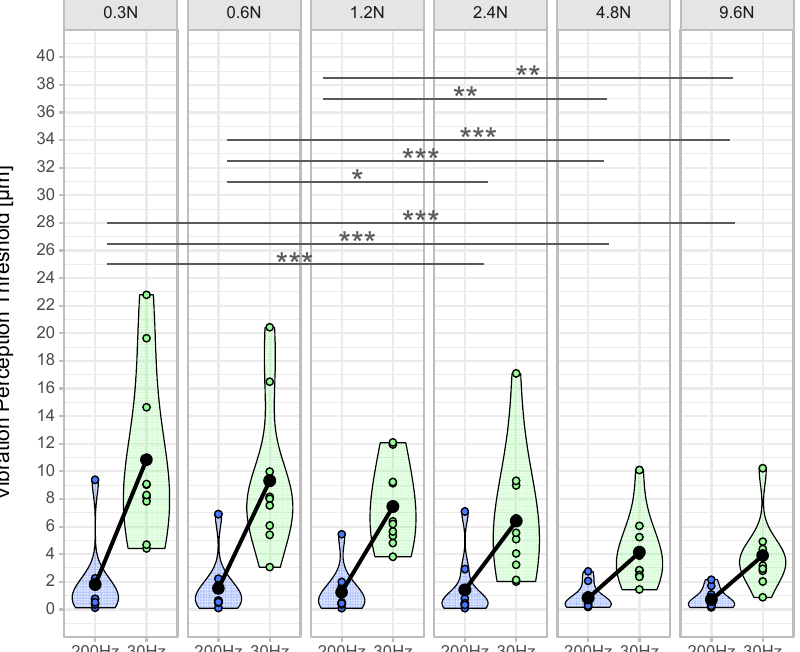
Figure 4. Vibration perception thresholds per contact force and frequency. The violin plots show the density of the distribution for the vibration perception thresholds (VPT) for the frequencies 200 Hz (blue) and 30 Hz (green) of the respective contact forces based on the width of the plot ( n = 10 per contact force condition). The individual points within the violin plots represent the averaged VPT (mean out of three VPT measurements per contact force condition) of each subject. The black dot is the mean value of all subjects. The connecting line between the black dots represents the mean difference. Superscripted symbols represent significant interaction contrasts and differences of the differences (*** p < 0.001, ** p < 0.01, * p < 0.05).